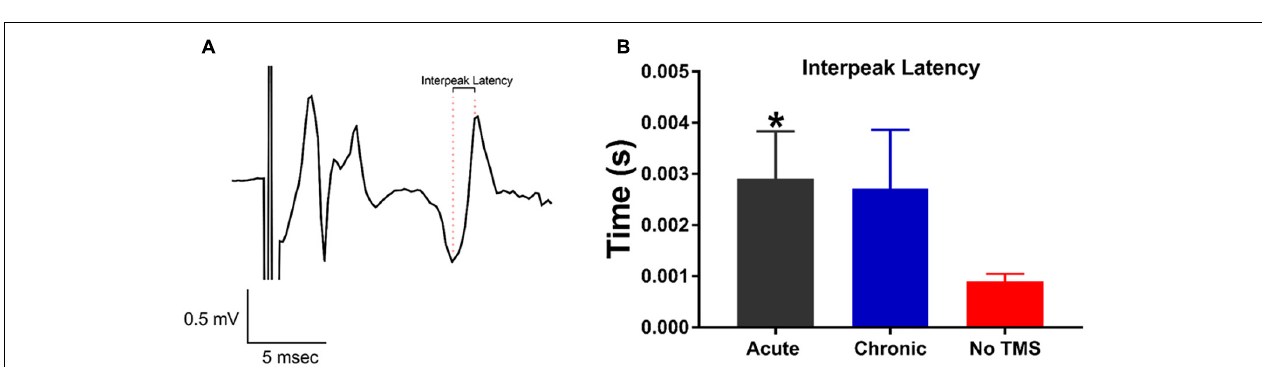
FIGURE 3 | MEP responses recorded from the forepaws evoked by transcranial magnetic stimulation (TMS) pulses. (A) Representative MEP trace showing the distance in time between consecutive maximal peaks defined as inter-peak latency. (B) Data summary show a significant increase in inter-peak latency in rats treated with acute-TMS vs the no-TMS group ( p = 0.018, denoted by ∗ ). The chronic vs. no-TMS group did not show significant differences in inter-peak